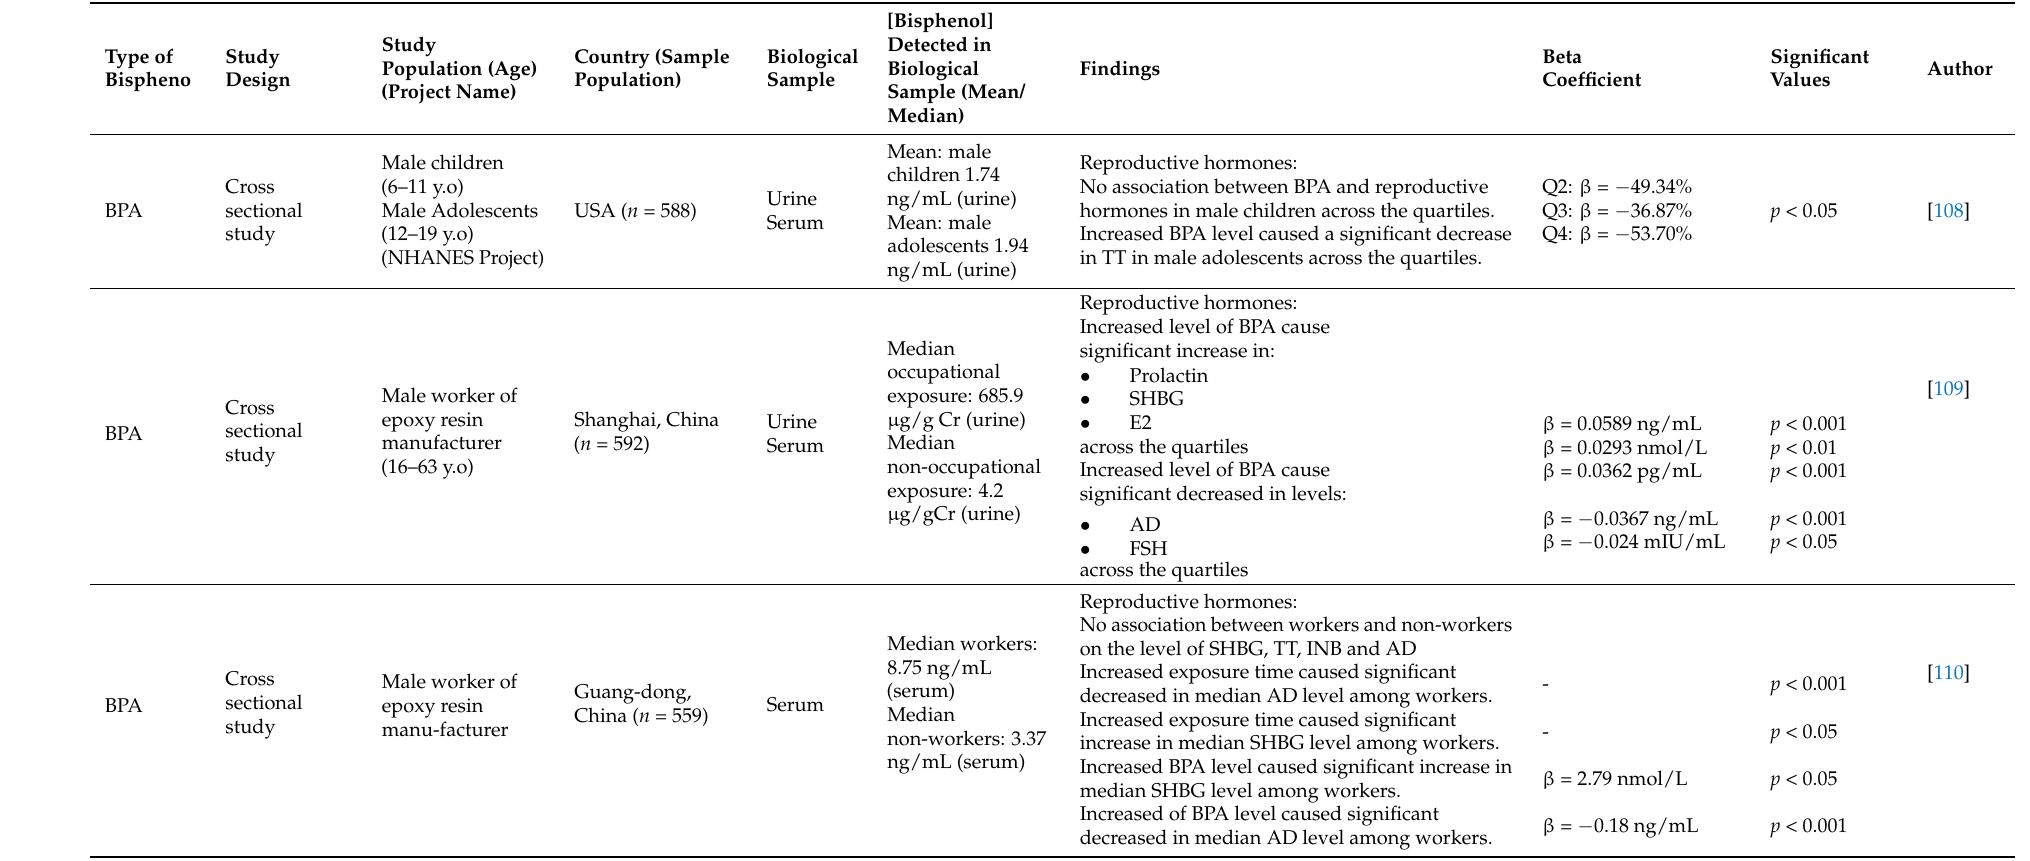
Table 4. The summary of human epidemiological studies of BPA and its analogues towards male reproductive